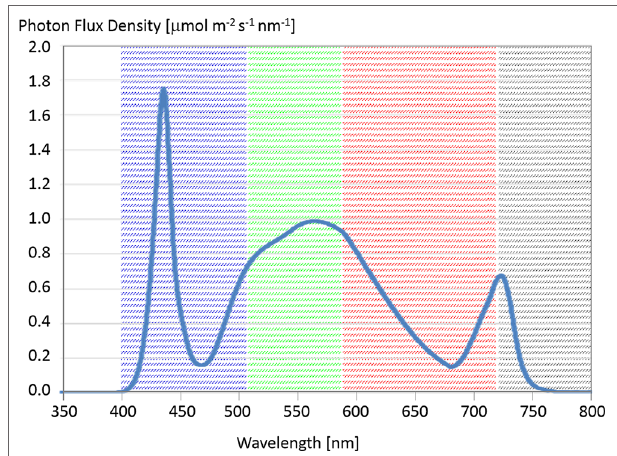
FIGUrE 2 | Spectral flux density (at 15-cm distance) of a LED panel set to 0% blue, 0% red, 100% white, 100% far red. There can be variation in spectral composition ±5% between individual LED panels (Source Heliospectra). The highlighted wavebands give roughly the extent of the blue, green, and red channels in the camera. The gray area shows the cut-off of the internal Near IR (NIR) filter, which was removed in the GoPro, to make it sensitive to that part of the